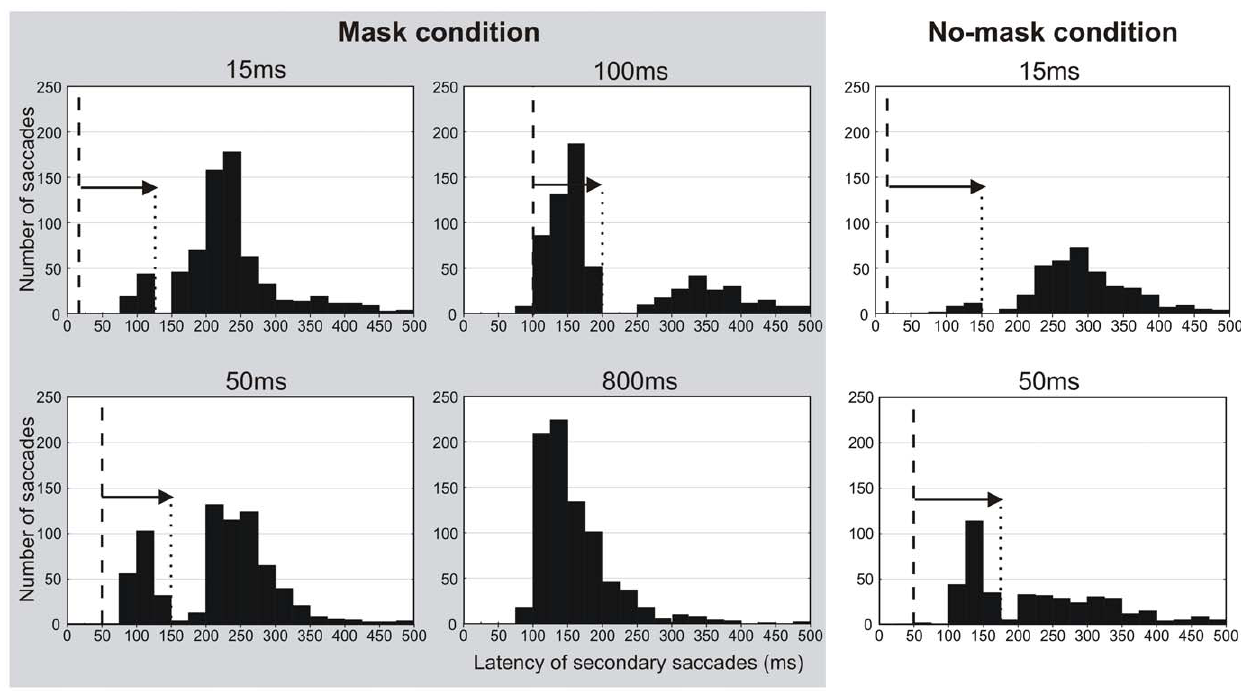
Figure 4. Latencies of secondary saccades in adaptation sessions of reactive saccades. Latency distribution of secondary saccades (first saccades following primary saccades, whether corrective or not) measured in the adaptation sessions of reactive saccades. Different target durations (15, 50, 100 and 800 ms) are shown in the different plots for the mask condition (grey background) and the no-mask condition (white background). Note a dip in distributions (arrow and dotted lines) around 100 ms (mask condition) or 125–135 ms (no-mask condition) after the disappearance of the stepped target (vertical dashed line).